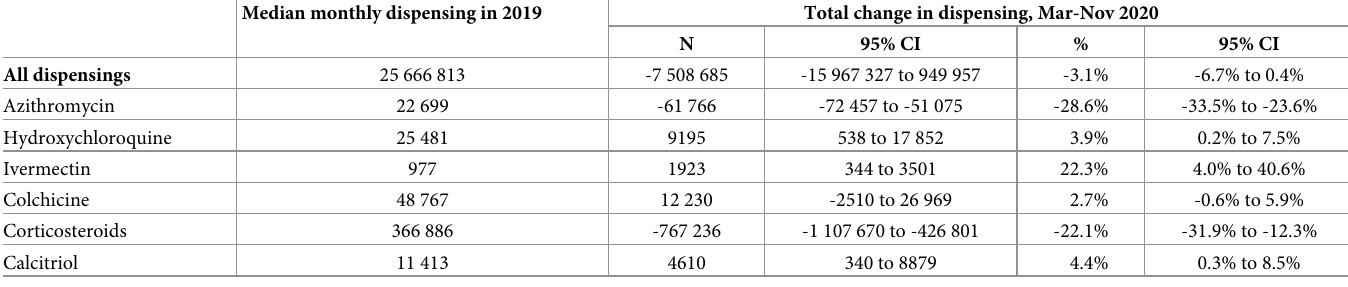
Table 1. Change in dispensing from March to November 2020 estimated using autoregressive integrated moving average models (ARIMA) with full aggregate s85 dispensing data.